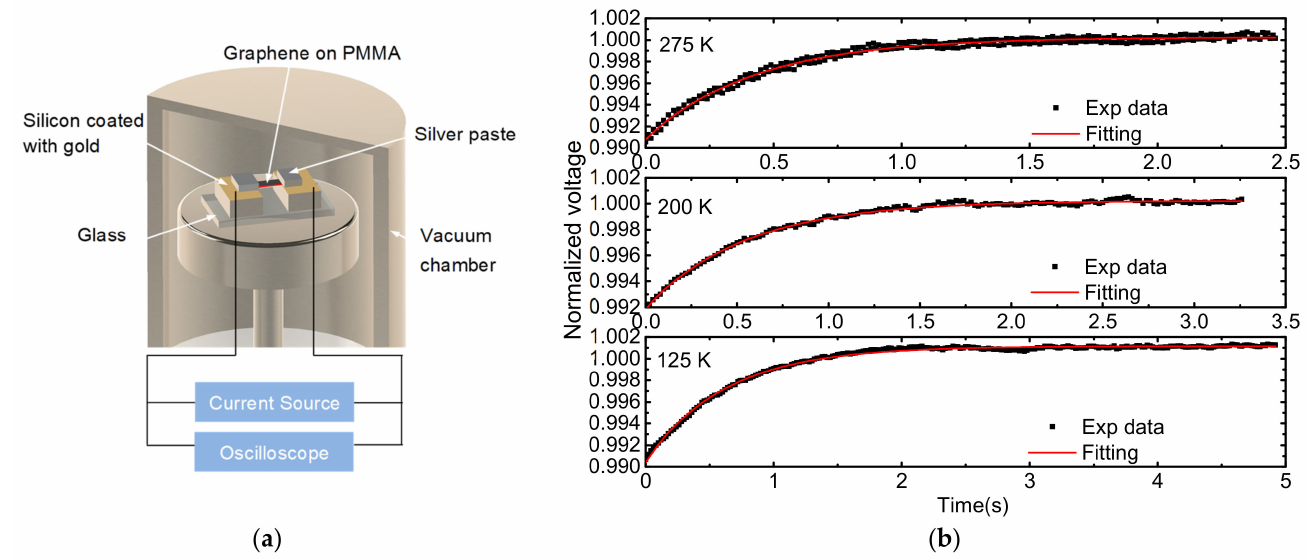
Figure 3. ( a ) Schematic setup of the TET measurement (not to scale); ( b ) Normalized voltage evolution and the fitting curve for S1 at 275, 200, and 125